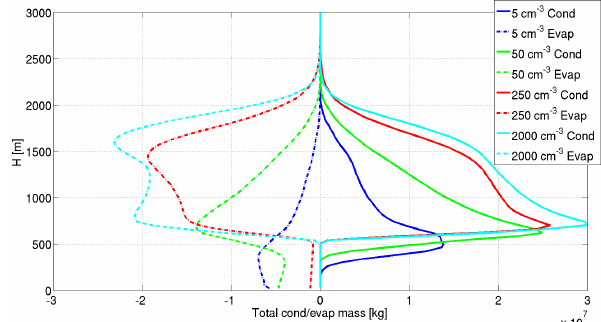
Figure 2. Domain’s total condensed (solid lines) and evaporated mass (dashed lines) for 14h of simulation along four different simulations conducted with different aerosol concentration levels (5cm − 3 – blue; 50cm − 3 – green; 250cm − 3 – red; and 2000cm − 3 –